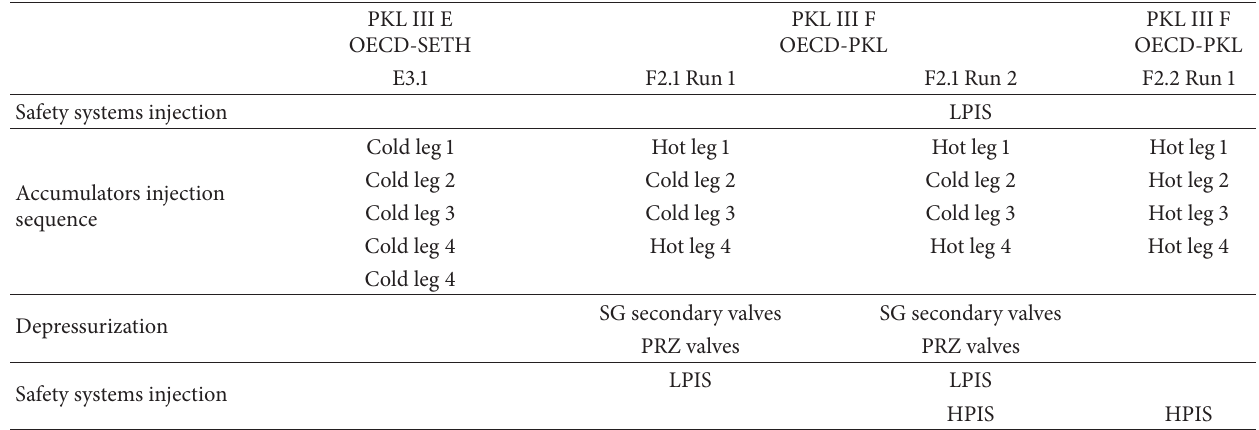
Table 2: E3.1, F2.1, and F2.2 accident management measures (Phase